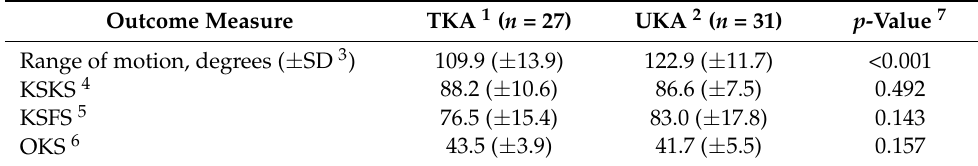
Table 3. Post-operative Range of Motion and Functional